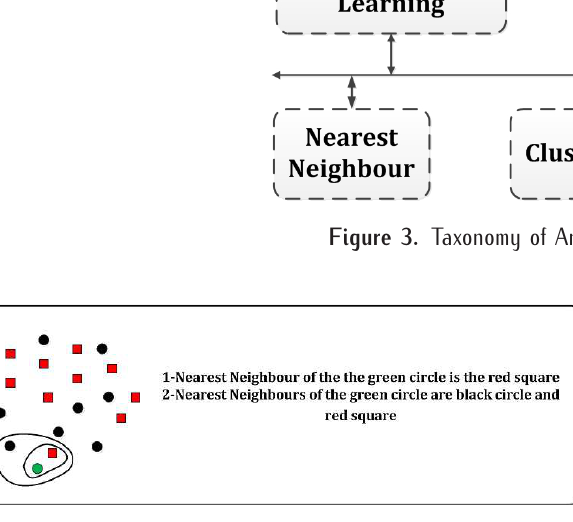
Figure 4. How k-NN works